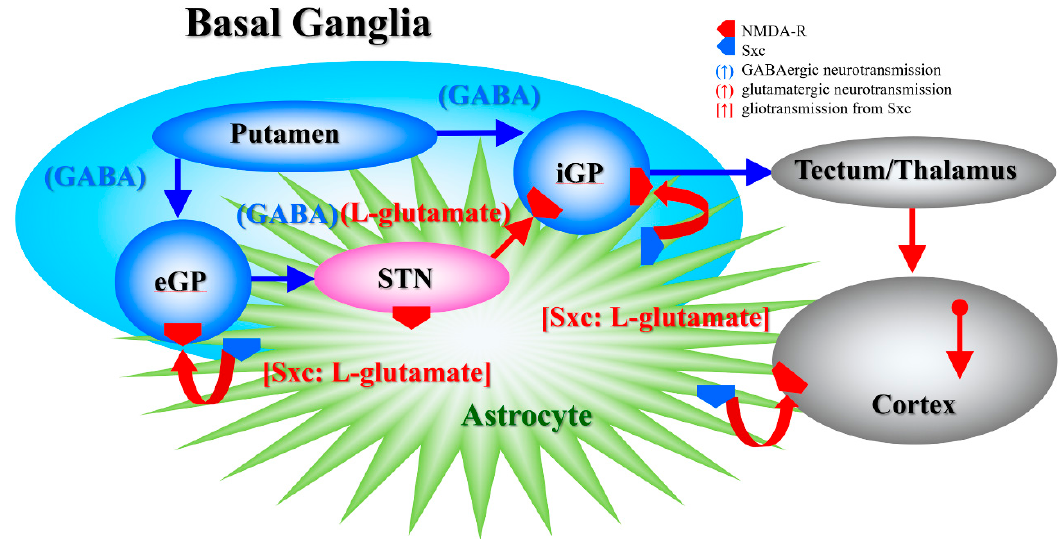
Figure 7. Our proposed hypothesis for the extended neural circuitry involved in the activation of L-glutamate release induced by MK801 and AMA in the internal globus pallidus (iGP: in rodents, the entopeduncular nucleus), external globus pallidus (eGP: in rodents, the globus pallidus) and entorhinal cortex. The putamen projects GABAergic terminals to both the eGP and iGP [50]. The eGP projects GABAergic terminals to the subthalamic nucleus (STN). The iGP receives glutamatergic projections from the STN and GABAergic projections from the putamen [50]. Cortical regions receive two major glutamatergic projections from other cortical regions and outside of the cortex. Inhibition of NMDA-R in the cortex did not affect L-glutamate release in previous studies [22,33,48,51], similar to the present results.